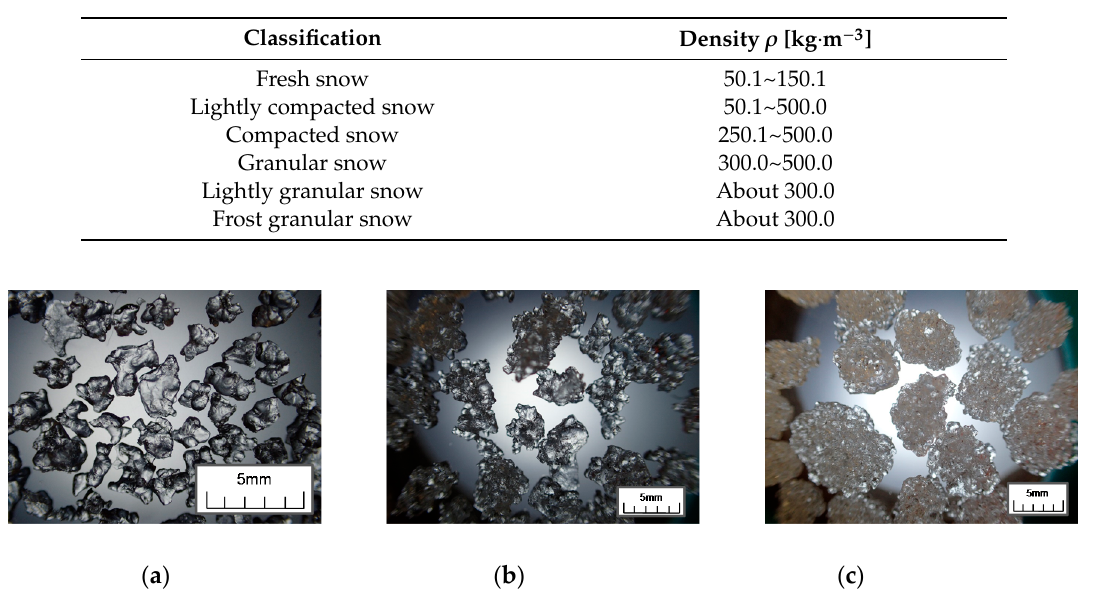
Table 1. Classification of snow quality according to the density of the snow [19].